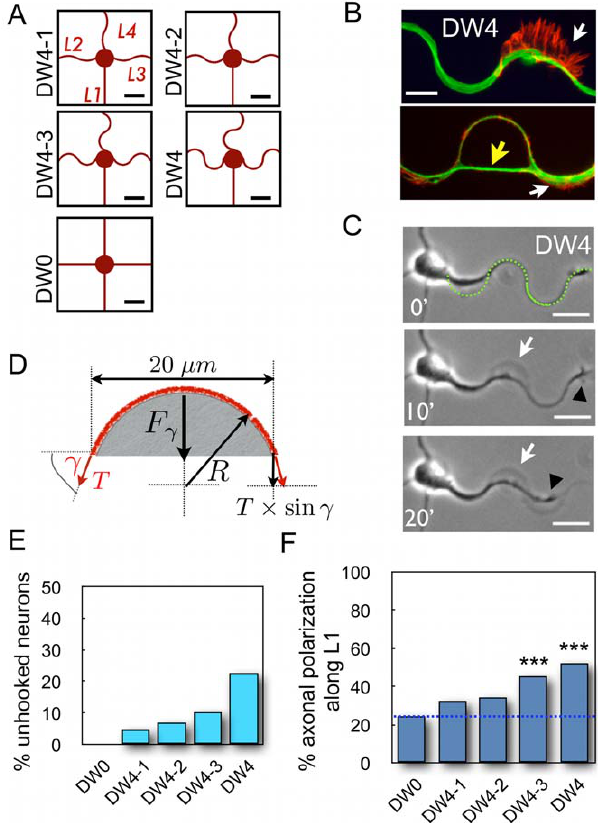
Figure 4. Influence of neurite curvature on axonal polarization. (A) DW4 set of patterns of increasing curvature along directions L2–L4; Scale bars, 20 m m. (B) Partial and complete unhookings observed on fixed cells (microtubules: green, F-actin: red). White arrows point to partial unhooking, characterized by a displaced neuritic shaft still attached to the substrate by a large lamellipodium. The yellow arrow indicates a complete unhooking characterized by a high density of MTs crossing the pattern arch and remaining entities strictly following the curved adhesive line. Scale bar, 10 m m. (C) Time-lapse experiment (indicated in minutes, beginning 30 hours after plating) of a neurite developing on a DW4 pattern showing partial unhooking (white arrow). The black arrowhead points to the neurite tip and the green dashed line marks the position of the adhesive pattern. Scale bars, 20 m m. Refer to Movie S1 for the original time-lapse sequence. (D) Physical modeling of a curved neurite (in red) as an elastic wire under tension T . Curvature is reflected by the angle c (see text), and F c =2 T sin c (black arrow) is the force experienced by the elastic wire. (E) Percentages of neurons displaying unhookings when grown over DW0 (0%), DW4-1 (4.7%), DW4-2 (7.0%), DW4-3 (10.6%), and DW4 (22.7%) patterns. ( n =117, 129, 128, 132, and 132, respectively). (F) Preferential axonal specification along the straight direction L1 were plotted from stage 3 neurons plated over DW0 (24.4%), DW4-1 (32.6%), DW4-1 (34.7%),